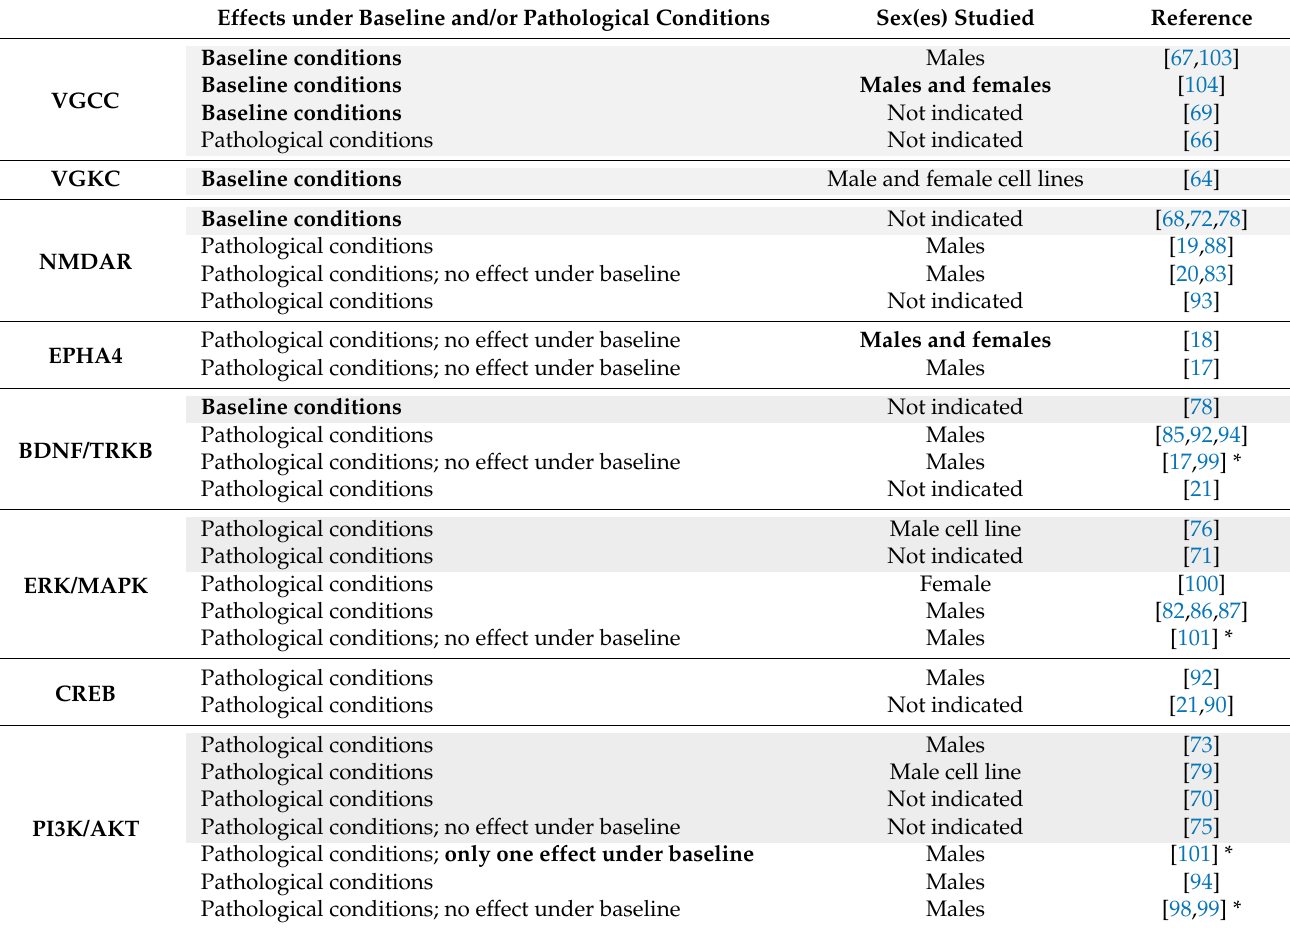
Table 2. List of literature showing effects of Rhynchophylline (Rhy) on sleep-related pathways under physiological (baseline) and/or pathological (disease-modeled)